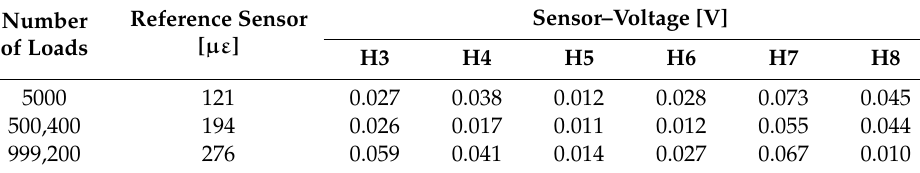
Figure 7. Measurement of strain and sensor voltage for reference and H3 sensor. Table 2. Evolution of deformation and voltage versus number of loads.